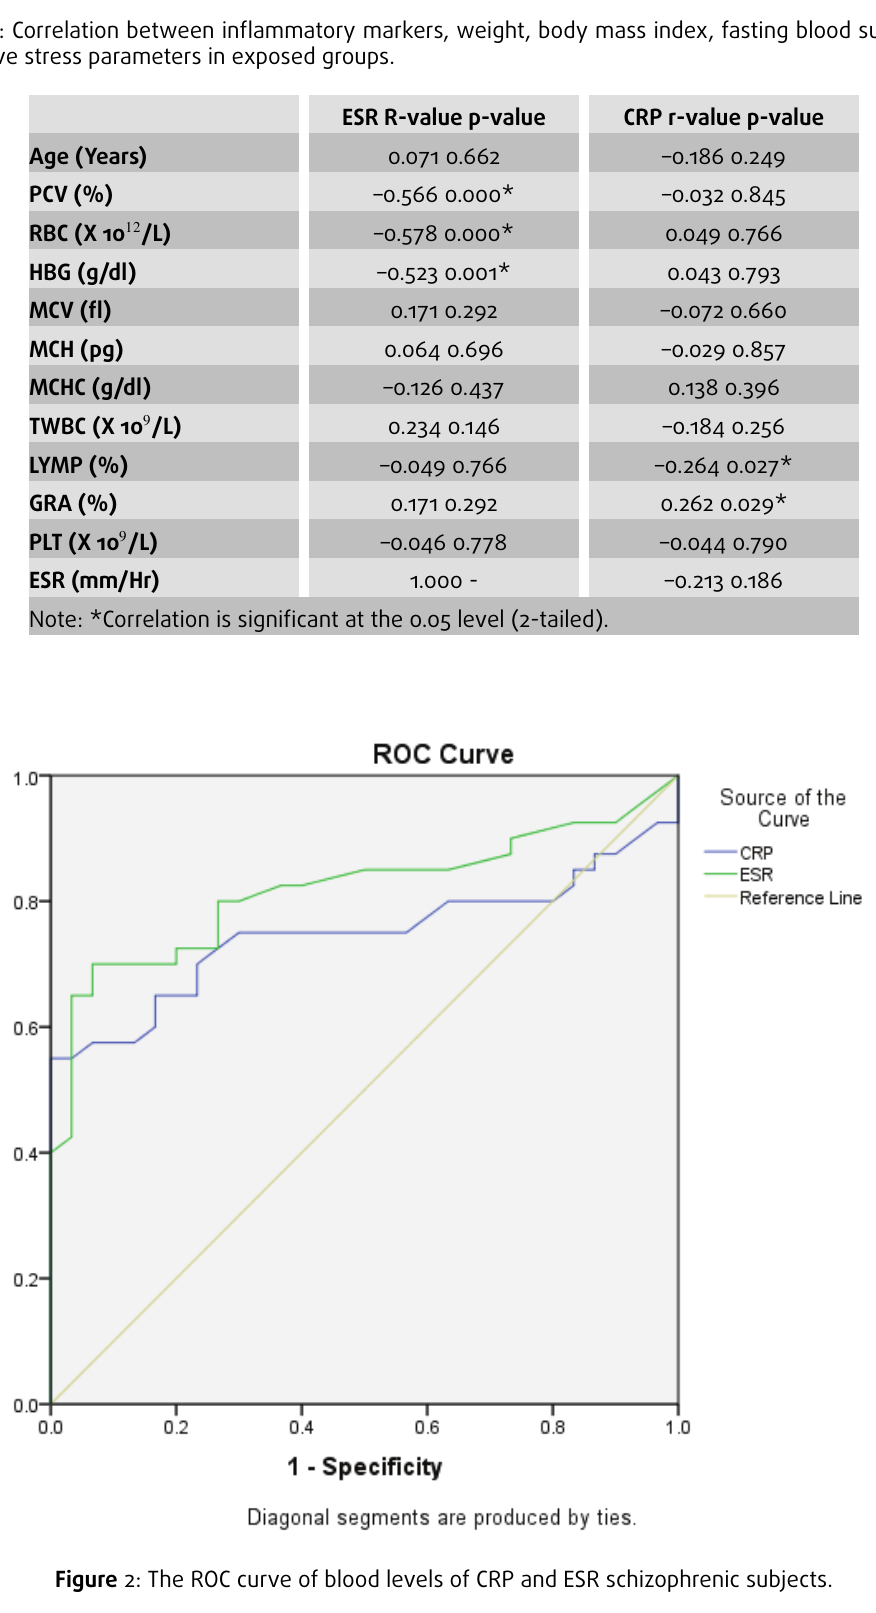
Figure 2: The ROC curve of blood levels of CRP and ESR schizophrenic